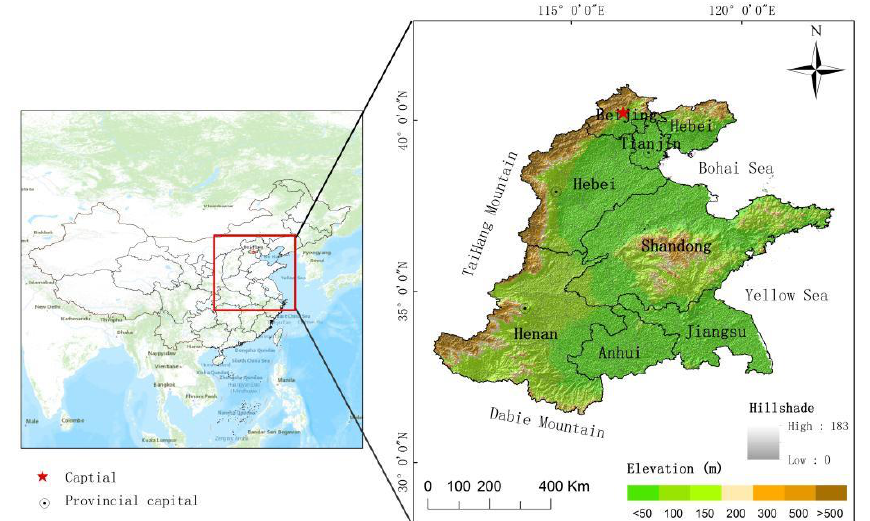
Figure 1. The geographical location of the study